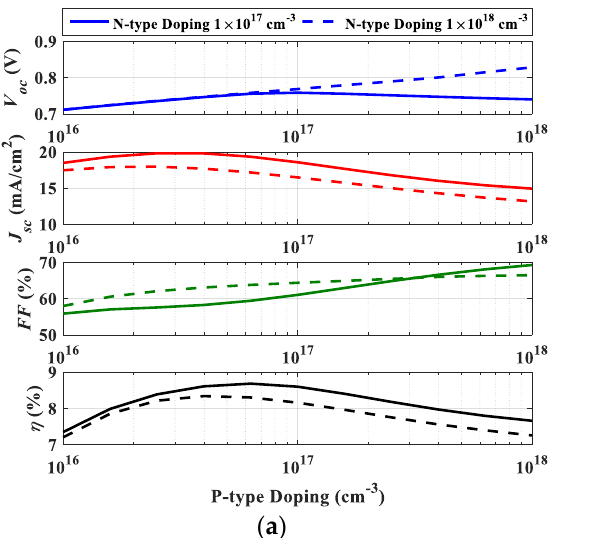
( b ) Figure 14. Impact of different metal contacts with distinct work function values on the HTL-free configuration photovol- taic parameters. ( a ) Photovoltaic parameters, and ( b ) energy band diagram drawn at the short-circuit condition for three different metal electrodes (work function values are also indicated).